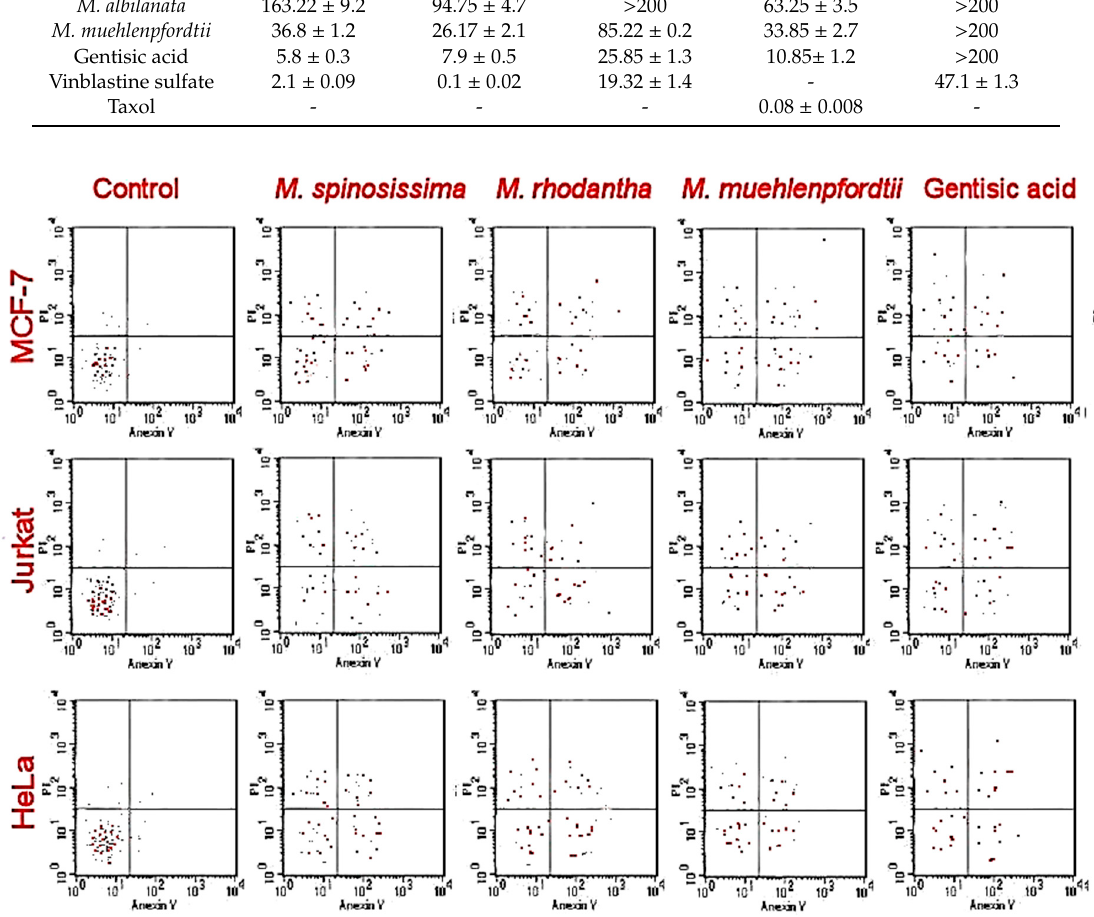
Figure 2. Apoptotic cell population (IC 50 ) using flow cytometry.